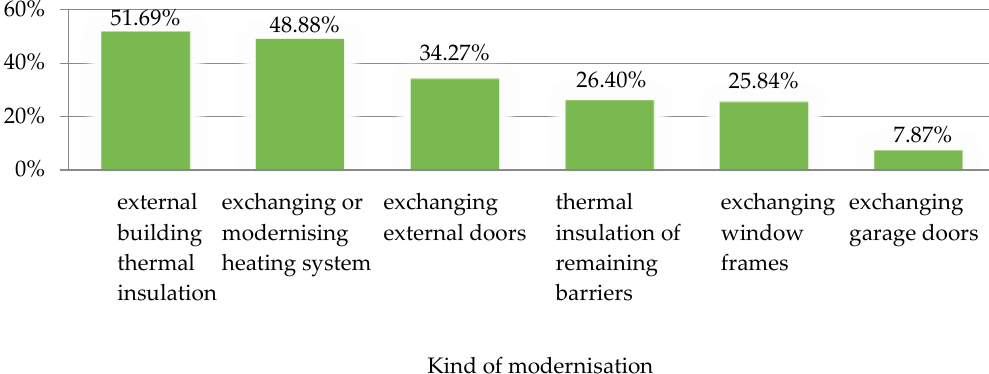
Figure 10. Modernisation works conducted in the residential buildings of the studied households. N = 178.